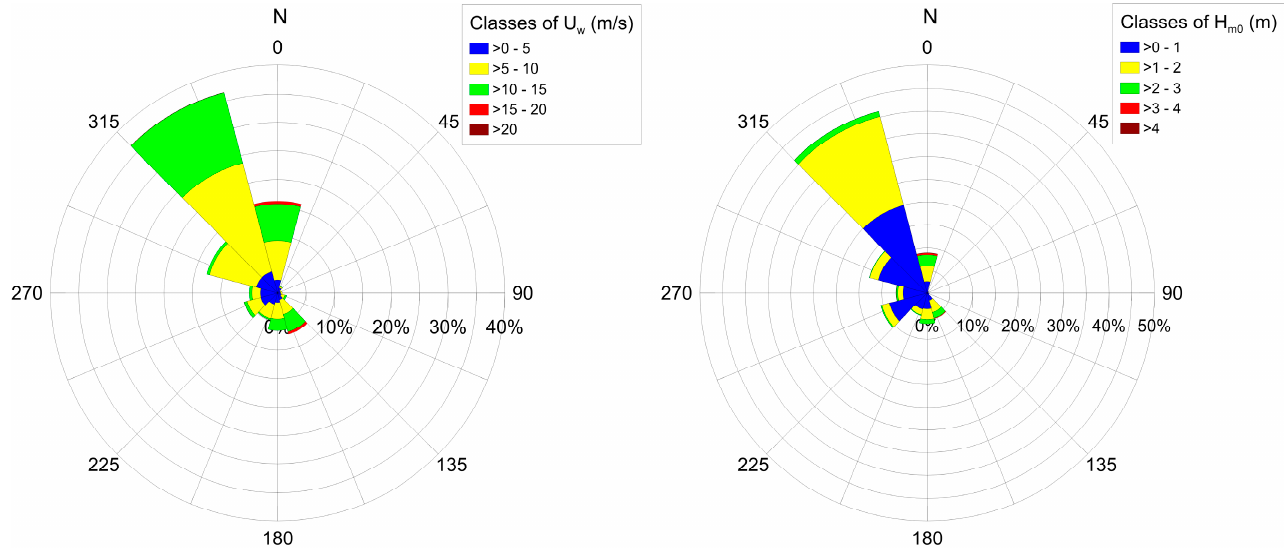
Figure 4. Rose diagram of wind velocity U w ( left ) and significant wave height H m 0 ( right ) in the year 2021.